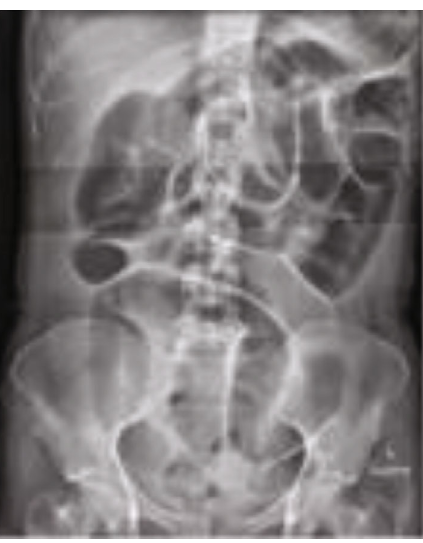
Figure 1: Abdominal X-ray image demonstrating multiple dilated loops of the small bowel.